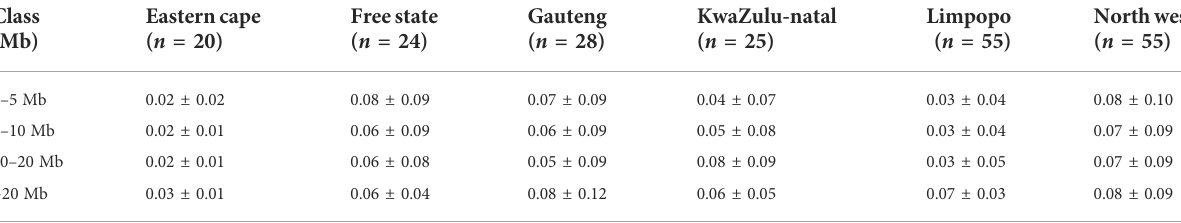
TABLE 1 Distribution of runs of homozygosity inbreeding coef fi cients ( F ROH ) within each population.